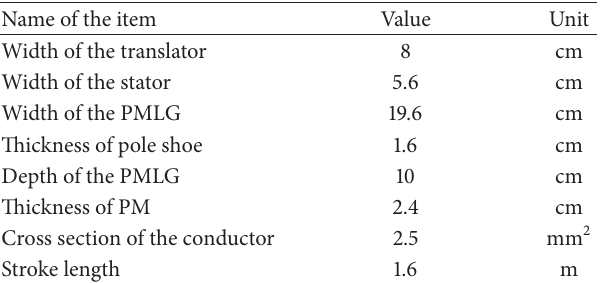
Table 4: Dimensions of the